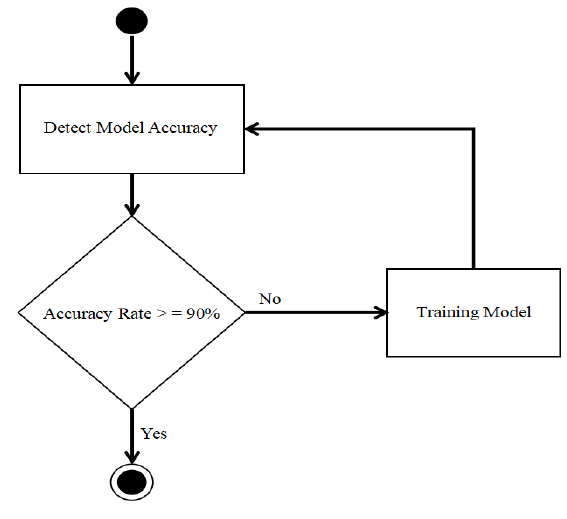
Figure 6. Model accuracy detection.